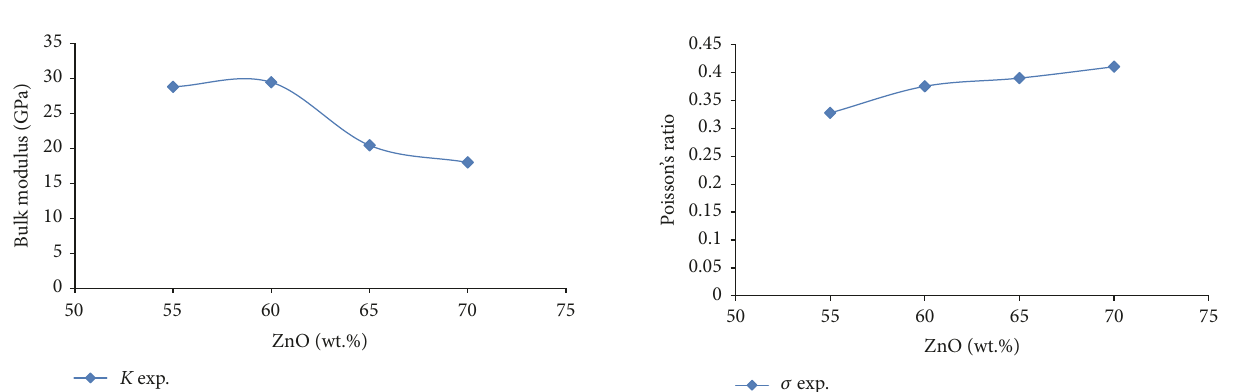
Figure 8: Poisson’s versus wt.% of ZnO in ZnO–SiO 2 samples.